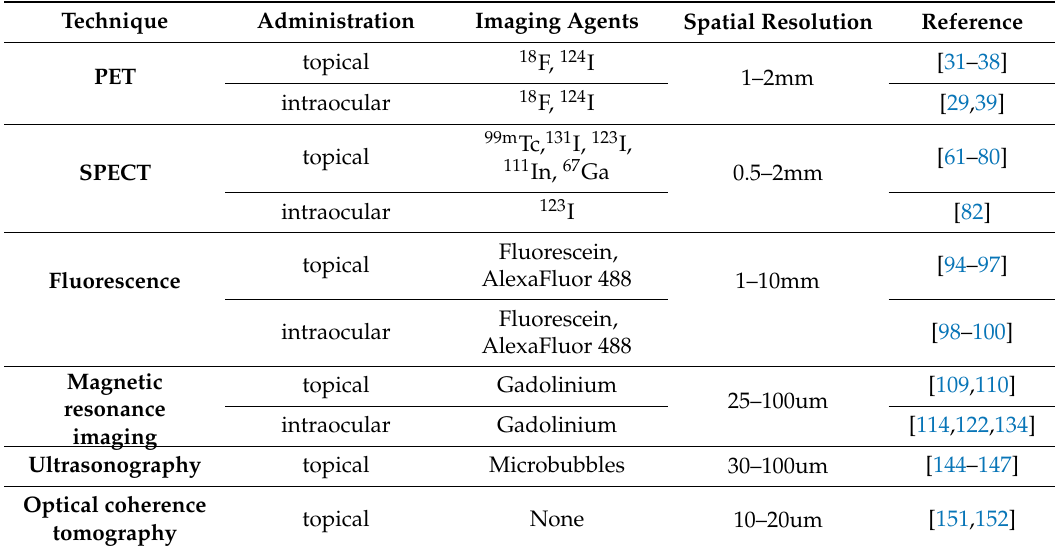
Table 1. Administration routes used in each molecular imaging technique, their imaging agents and spatial